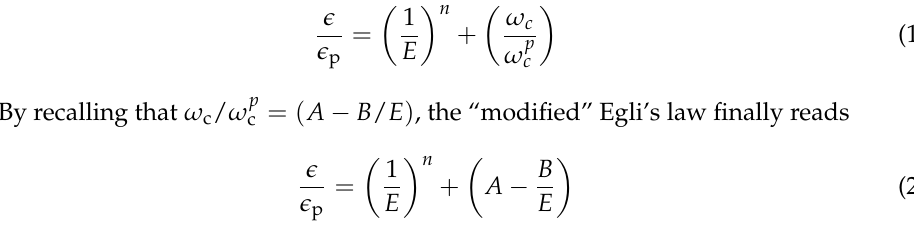
Figure 5. ( a ) DSC curves for a printed and foamed/printed PLA strand; ( b ) effect of expansion ratio on the crystallinity content—the dashed line is a guide for the eye.